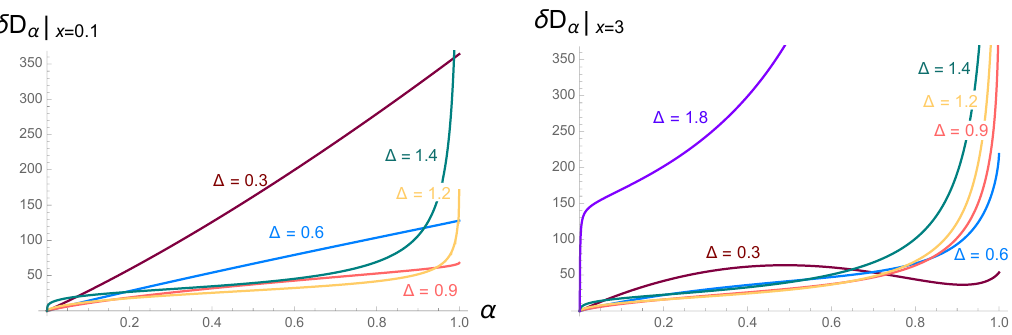
Figure 5 . (cid:14)D (cid:11) ( (cid:26) k (cid:26) ) = D (cid:11) ( (cid:26) k (cid:26) ) (cid:0) D (cid:11) ( (cid:26) (cid:12) k (cid:26) ) for x = 0 : 1 (left) and x = 3 (right). Here R R R (cid:21) = ~ (cid:21)= j (cid:1) (cid:0) 1 j and ~ (cid:21) (2 (cid:25)=(cid:12) ) (cid:1) (cid:0) 2 (cid:12)xed. In both plots (cid:1) = 0 : 3 ; 0 : 6 ; 0 : 9 ; 1 : 2 ; 1 : 4, (cid:12) = 2 (cid:25) and ~ (cid:15) = 0 : 001. (In the left panel we excluded the curve (cid:1) = 1 : 8, which has much bigger magnitude than the others.) In all curves we rescaled the prefactor ~ (cid:21) 2 c L 3 (cid:25) 2 2 5